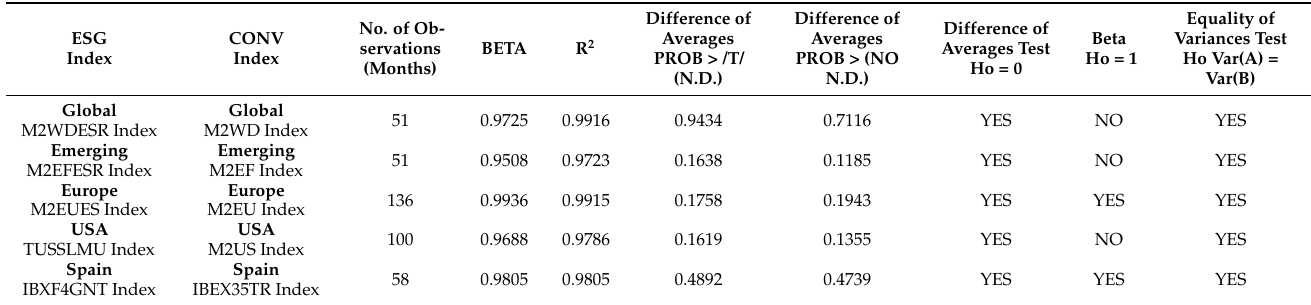
Table 8. Inferential